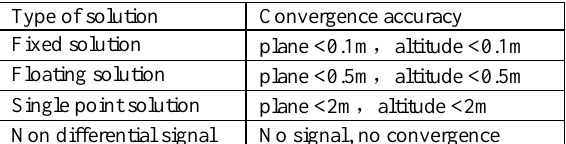
Table 4. differential observation of 50 point satellite stations